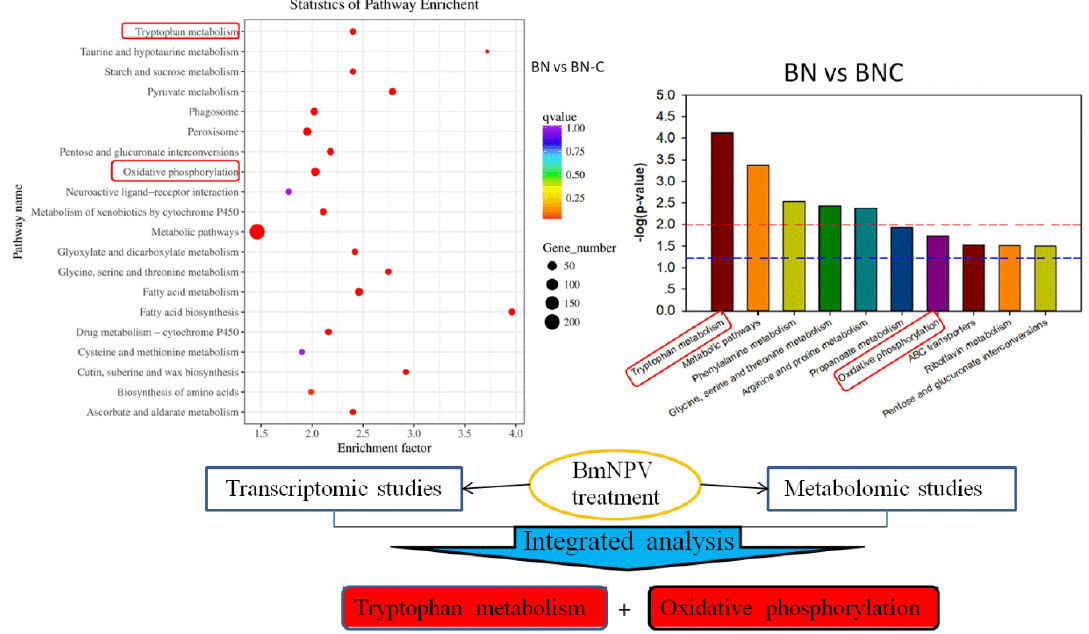
Figure 5. Integrated analysis of transcriptomic and metabolomic studies. The red boxes show overlapping results from both two –omics analyses.